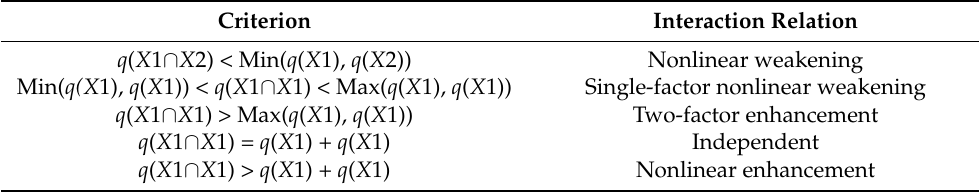
Table 1. Effects produced by the interaction between different environmental